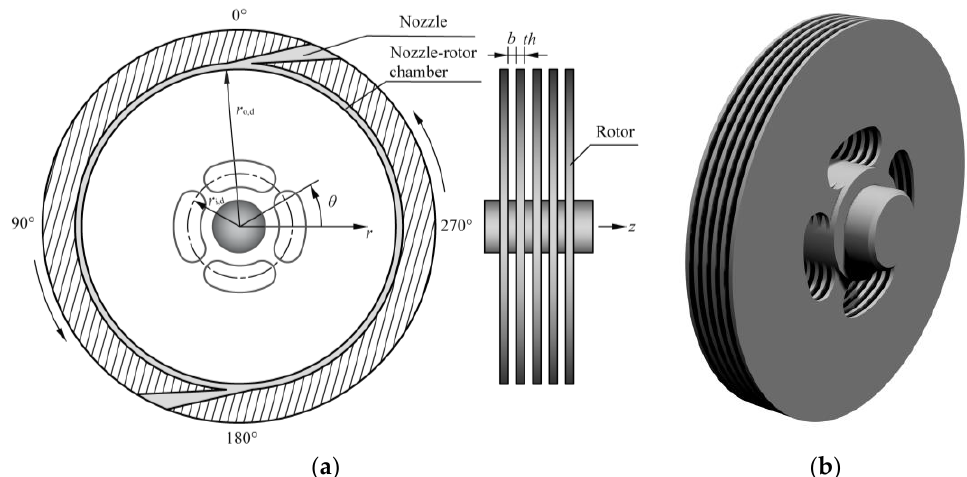
Figure 1. Tesla turbine schematic: ( a ) 2-D sketch; and ( b ) 3-D rotor.